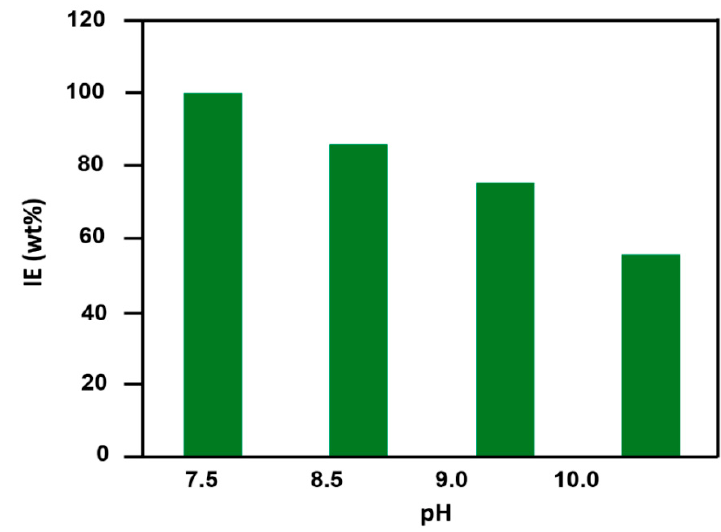
Figure 6. Influence of the pH of the media on the scale IE at 50 °C for a concentration of 10 mg·L − 1 of CA-co-GLC and 1000 mg·L − 1 of Ca 2+ .